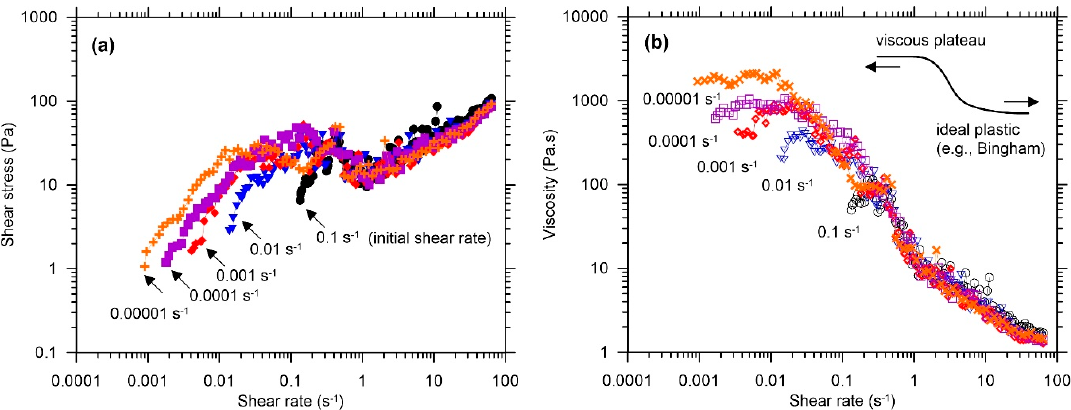
Figure 3. Shear rate dependency of rheological behavior at relatively low shear rates: ( a ) Shear stress-shear rate relationship and ( b ) viscosity-shear rate relationship